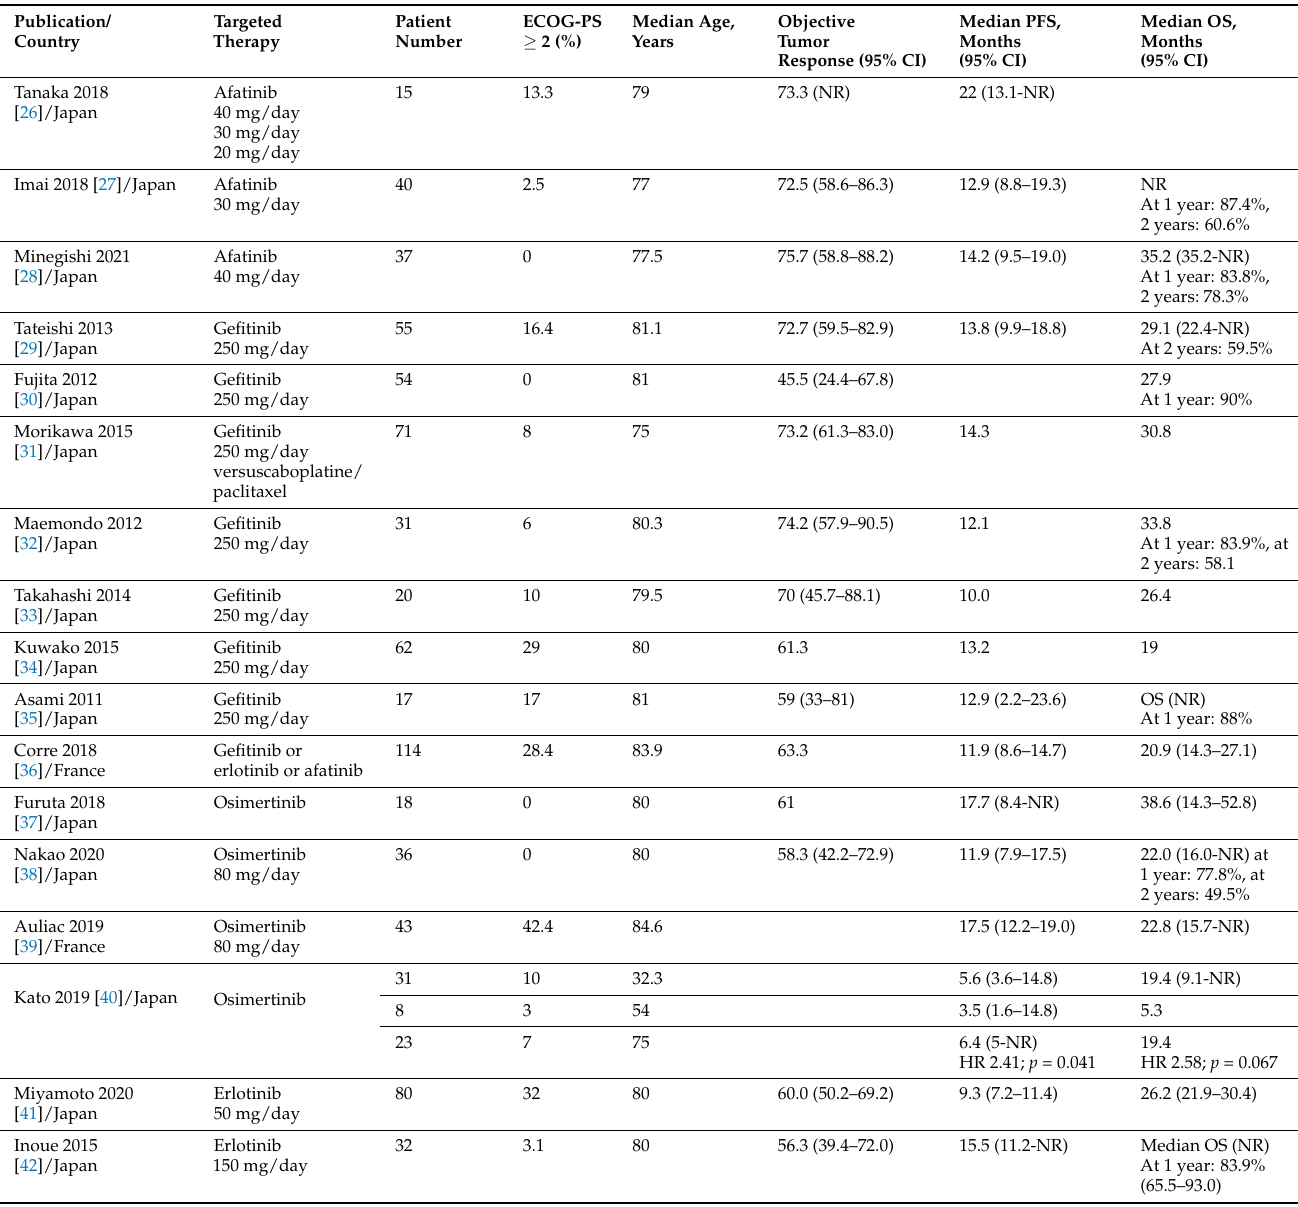
Table 1. Targeted therapy efficacy results in older patients in retrospective and prospective cohorts ( ≥ 65 years).